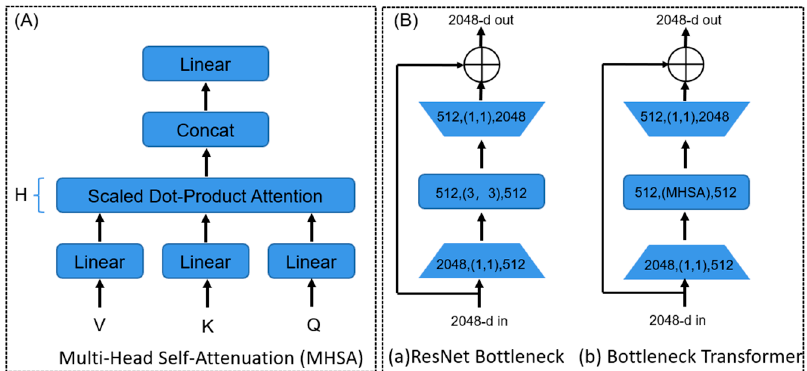
Figure 5. Multi-decoupled feature pyramid network. Information is extracted at different scales and fused to improve the targeting accuracy of the network. ( A ) is the MHSA network structure, and the principle is to perform self-attentive transformations on Q, K, and V (V is the value vector, Q is the query vector, and K is the key vector) in the MHSA module. In ( B ), ( a ) represents the improved backbone, and ( b ) is the improved backbone.